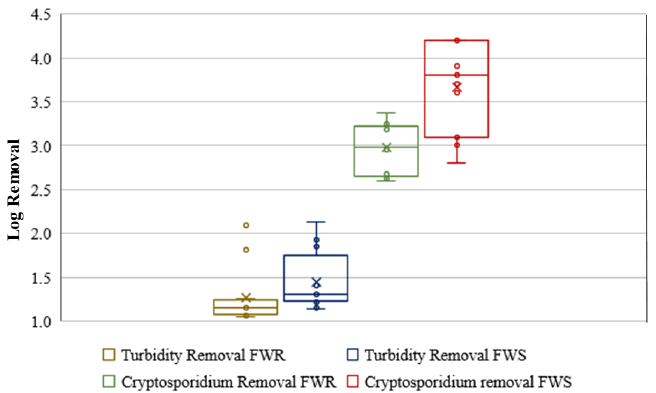
Figure 3. Comparative log removal of turbidity and of Cryptosporidium oocyst during ripening (FWR) and during stable operation (FWS).